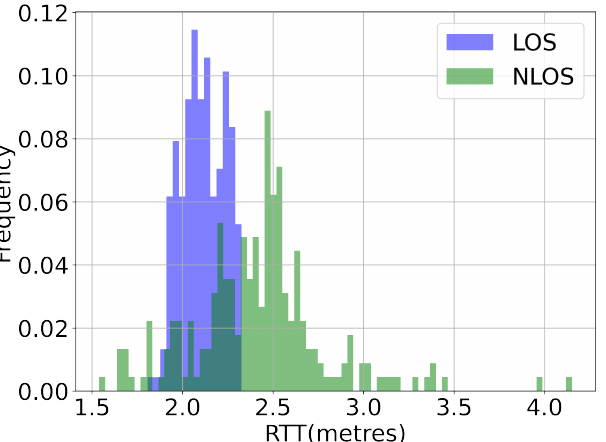
Figure 9. The WiFi RTT signal measure under different scenarios. A smartphone was placed 3 m away from the access point. We observed that in human NLOS experiment where the signal was blocked by human body, the RTT measurement became larger, more unreliable and further away from the ground truth distance measure.